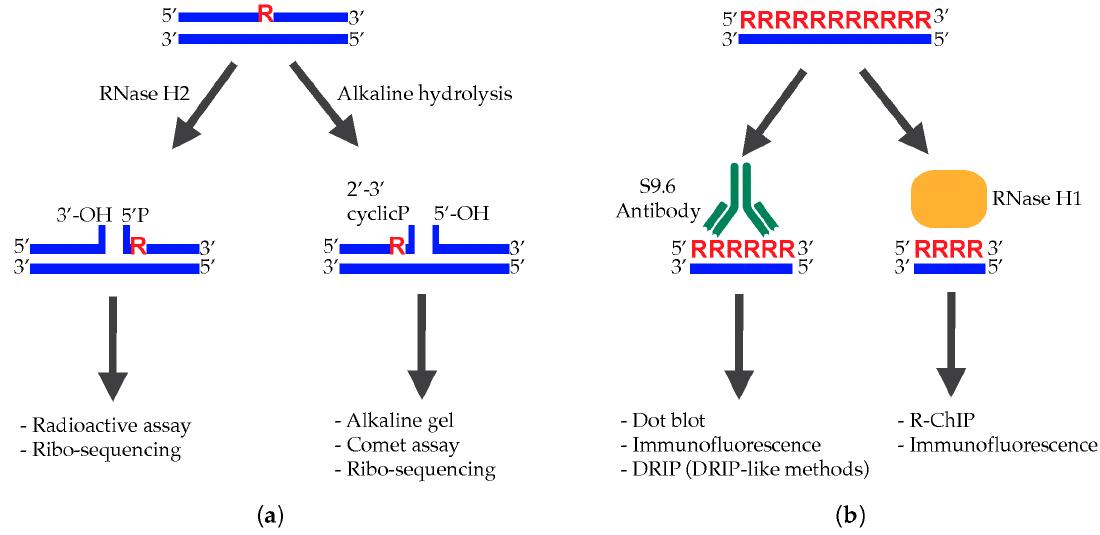
Figure 3. Currently available techniques for studying RNA in DNA. ( a ) The investigation of single ribonucleotides paired with DNA is based on enzymatic or chemical digestion in correspondence of rNMPs to generate single breaks in DNA. Different approaches can then be used to visualize and map the sites of rNMP insertion. ( b ) The main strategies developed to examine stretches of ribonucleotides hybridized with DNA rely on the S9.6 monoclonal antibody or on RNase H1, which allows recognizing RNA:DNA hybrids independently of their sequence. S9.6 binds DNA hybrids of at least 6 bp; RNase H1 detects hybrids of at least 4 bp.